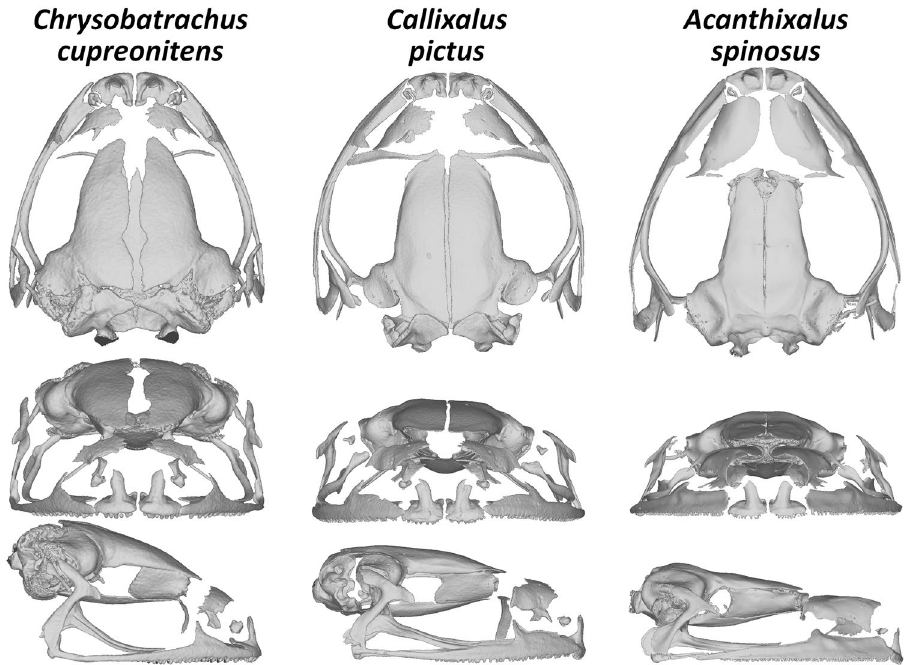
Chrysobatrachus cupreonitens (CAS 145263, male), Callixalus pictus (CAS 145260, male), and Acanthixalus spinosus (CAS 153800, female). Skull views are scaled to a similar size among the three